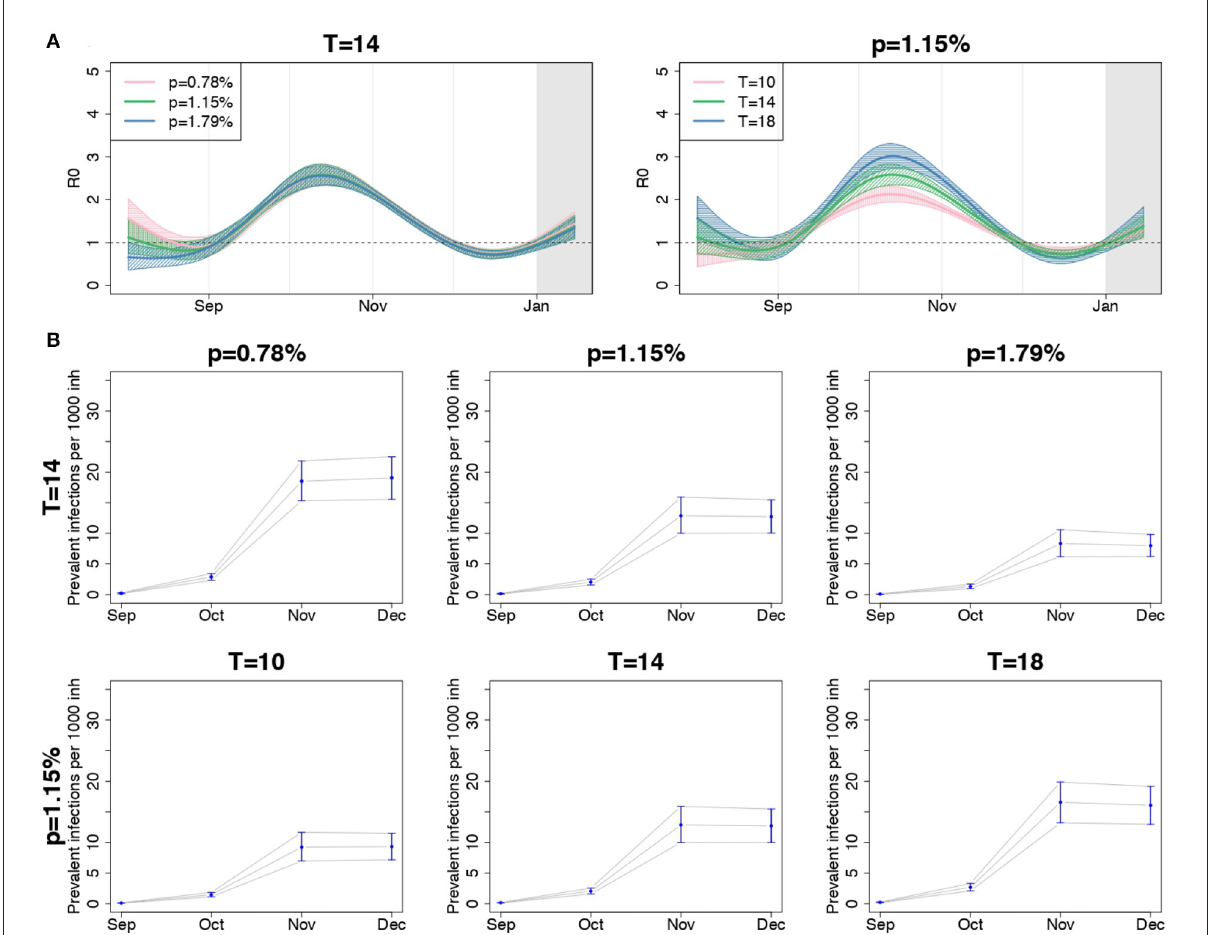
FIGURE5 (A) Posterior mean and 90% credible bands of the meta-analytic R 0 curves and (B) posterior mean and 90% credible intervals of the meta-analytic monthly-averaged prevalence per 1,000 inhabitants (second and third rows) for the entire country, when using different values for p , fixed T = 14 days, and when using different values for T , fixed p = 1.15 %